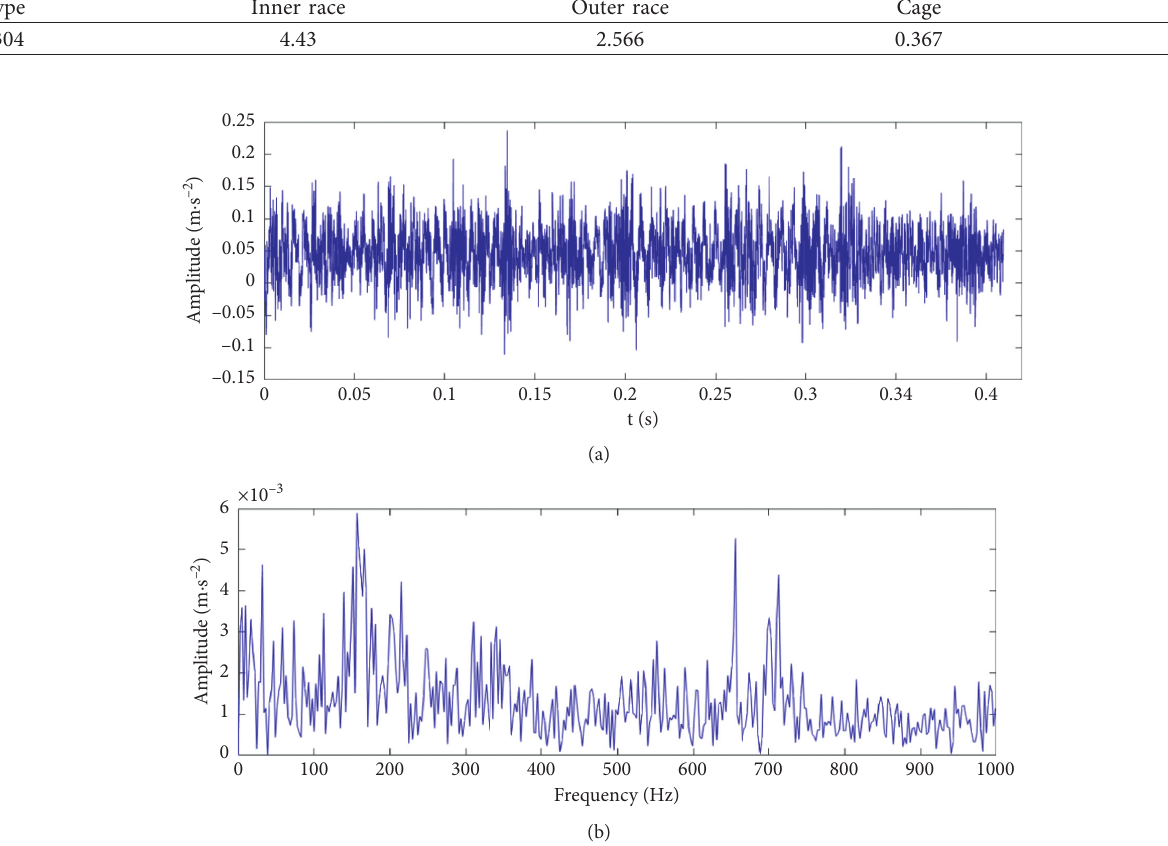
Figure 12: Waveform and envelope spectrum of inner race fault signal. (a) Waveform of fault signal. (b) Envelope spectrum of fault